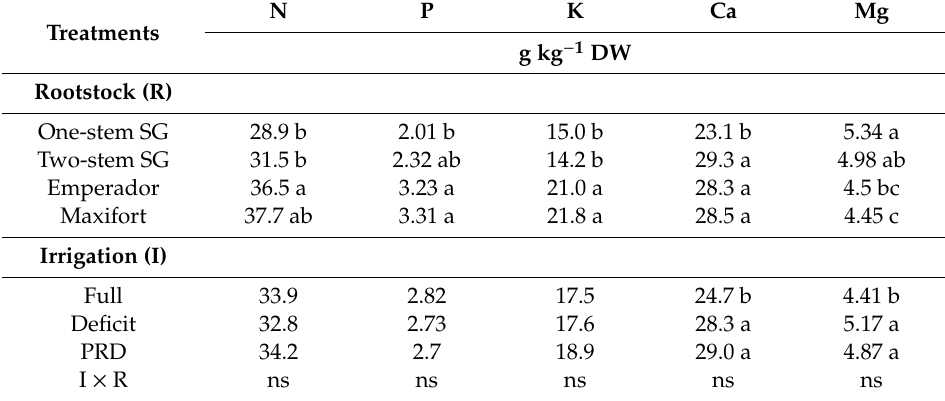
Table 6. Leaf mineral concentrations of self-grafted and grafted tomatoes grown under three irrigation techniques in the second year.